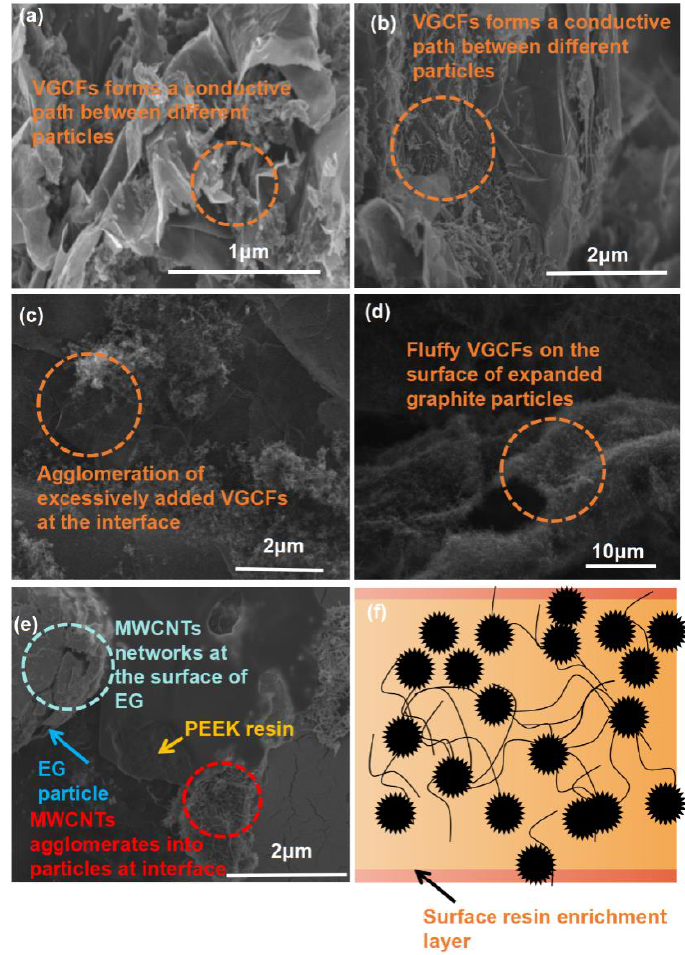
Figure 8. ( a ) VGCFs form conductive paths between particles; ( b ) VGCFs forming a network structure on the surface of graphite; ( c ) agglomeration of excessively added VGCFs at the interface; ( d ) VGCFs form a fluffy shape on the surface of expanded graphite particles Structure; ( e ) Agglomeration of MWCNTs in composite bipolar plates; ( f ) schematic diagram of VGCFs forming structure inside BP.